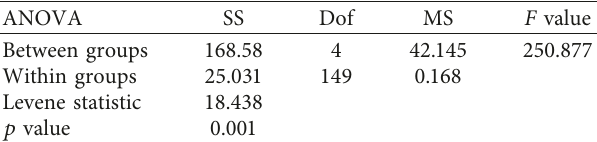
Table 4: ANOVA test between enhanced data privacy and ap- plication of blockchain technology in treating patients.